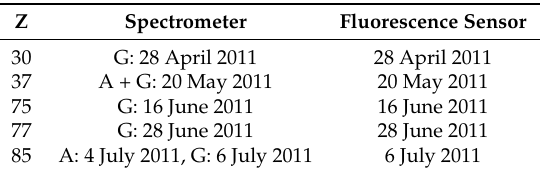
Table 2. Exemplary for the other site-years, the overview shows the dates for site-year 1 (2011) regarding ground and aerial sampling in the different growing stages (Z). A = aerial spectrometer, G = ground